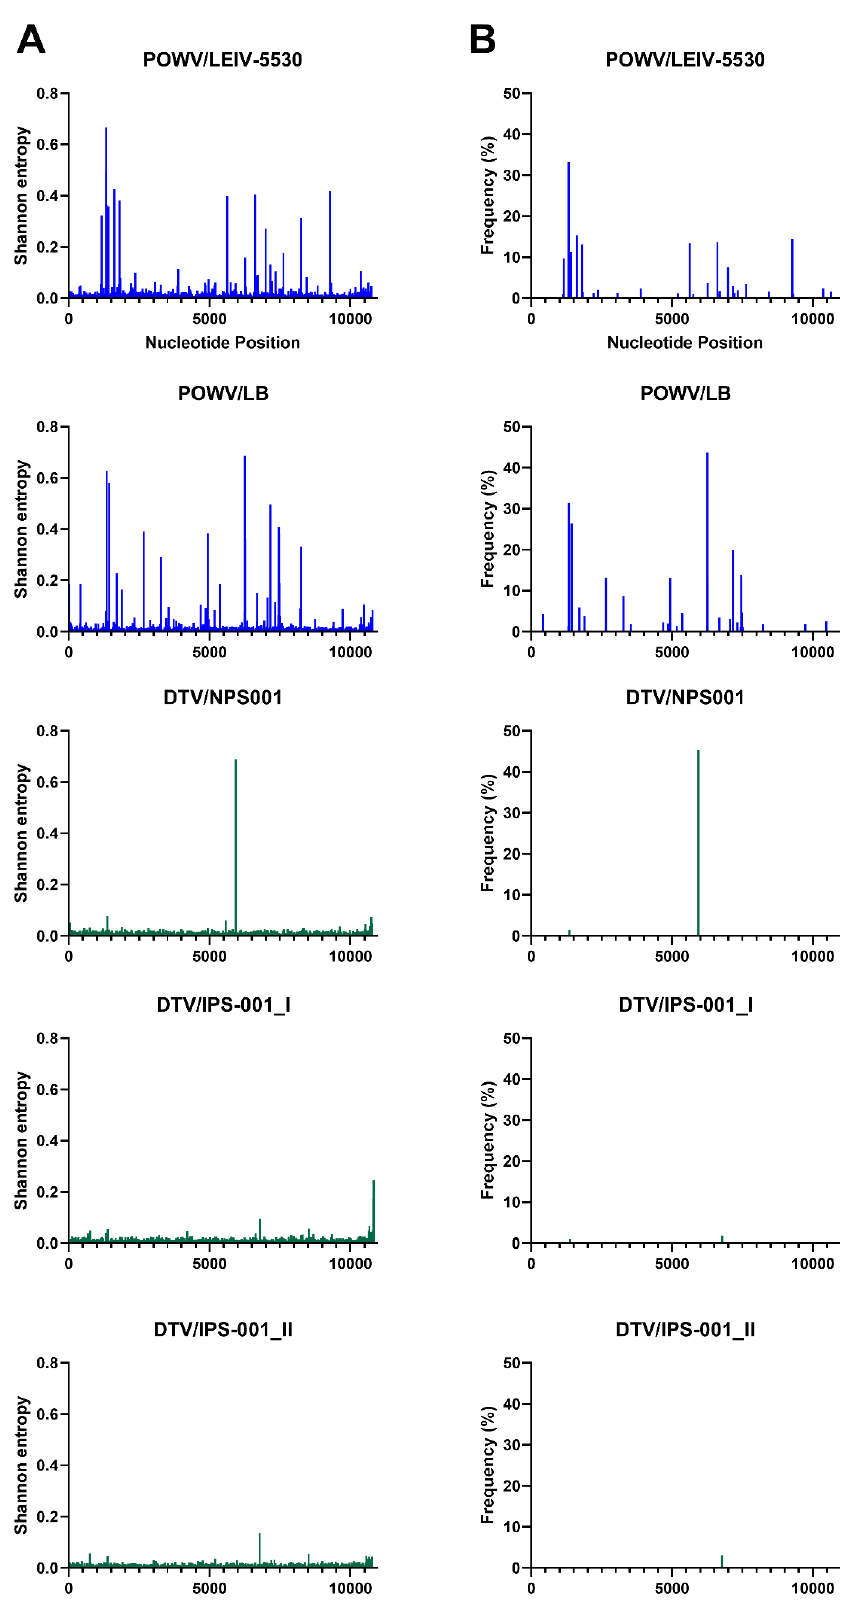
Figure 3. Shannon entropy ( A ) and SNVs ( B ) for each POWV and DTV sample. See Table 1 for details of each sample and virus sample